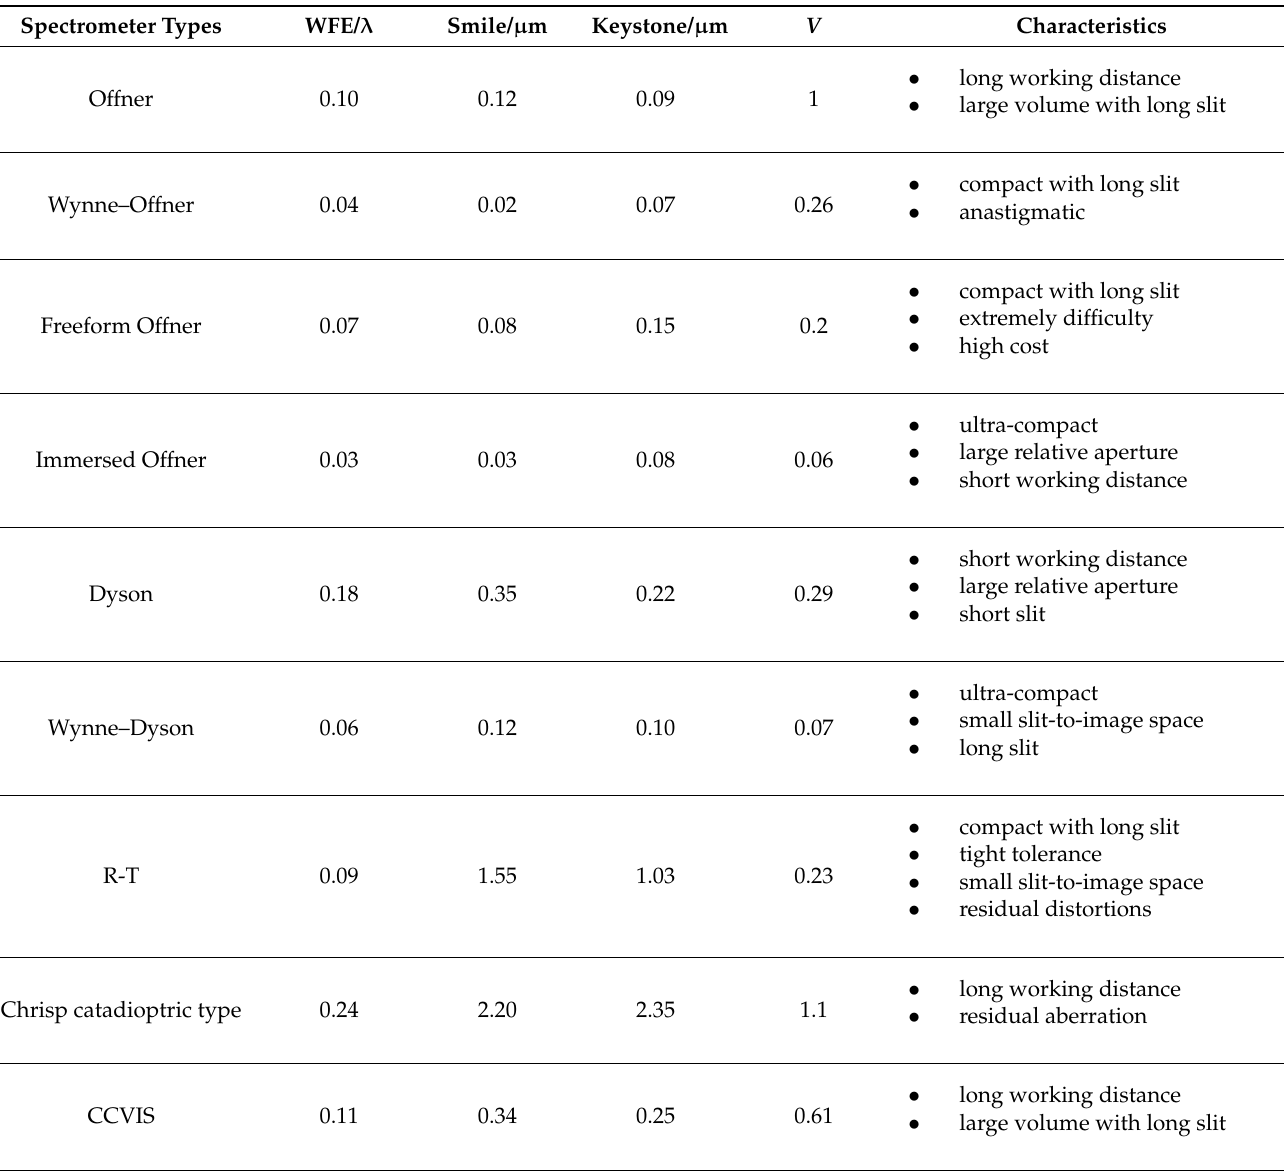
Table 3. Optical performance of the designed spectrometers and comparison of their